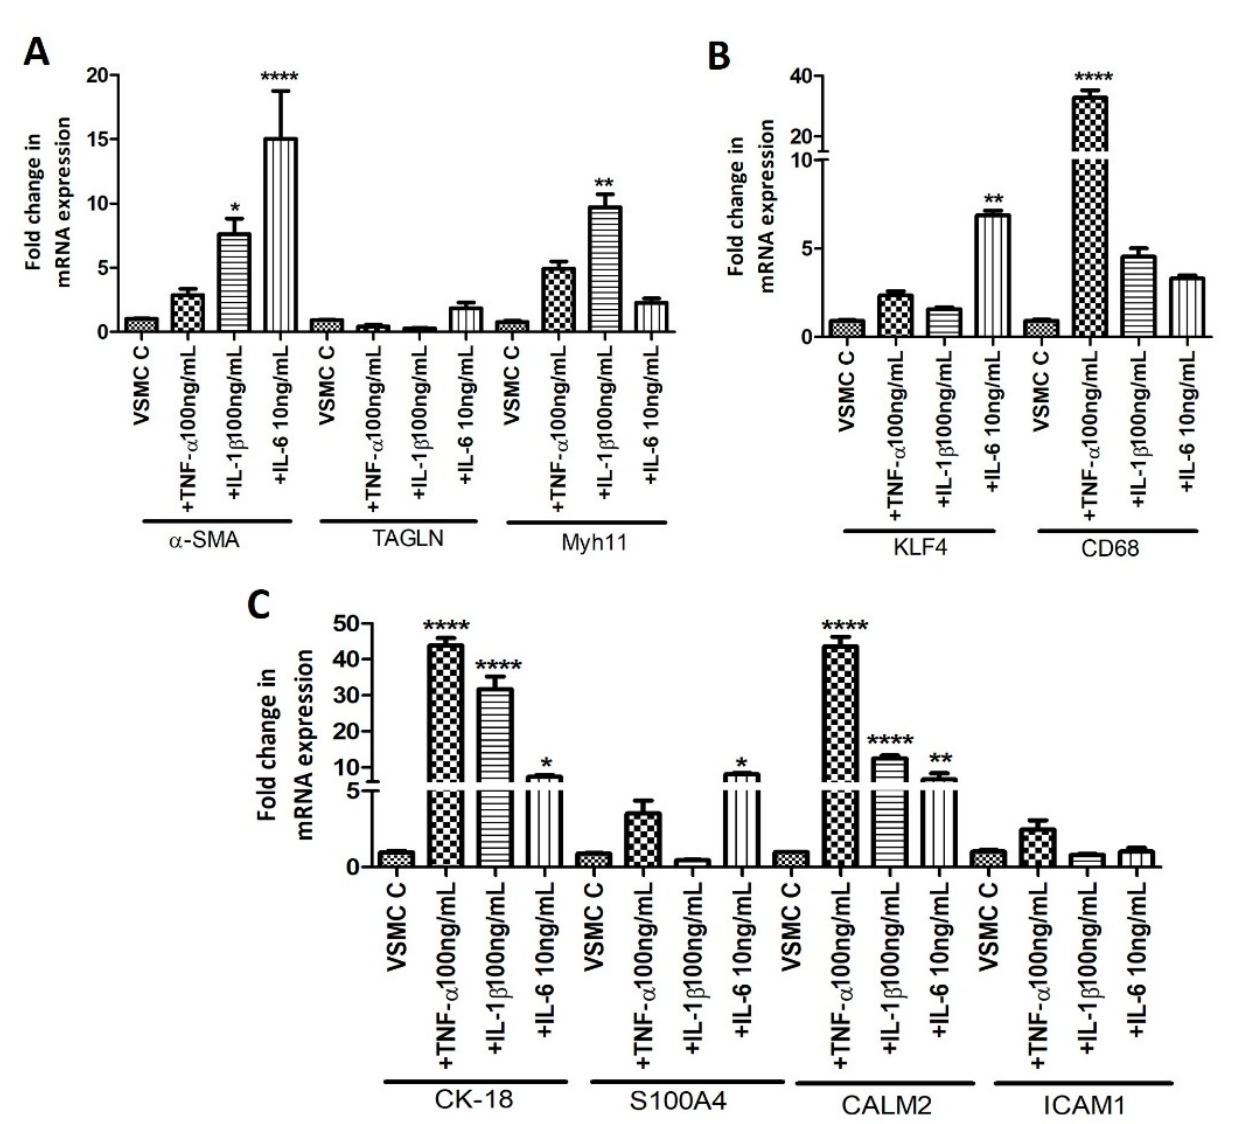
Figure 4. RT-qPCR data for the effects of pro-inflammatory cytokines IL-6, IL-1 β , and TNF- α on VSMCs phenotype markers. Panel ( A ) shows qRT-PCR data for α -SMA, TAGLN, and Myh11; Panel Figure 4. RT ‐ qPCR data for the effects of pro ‐ inflammatory cytokines IL ‐ 6, IL ‐ 1 β , and TNF ‐α on ( B ) shows qRT-PCR for CK-18, S100A4, CALM2, and ICAM1; and Panel ( C ) shows qRT-PCR for VSMCs phenotype markers. Panel ( A ) shows qRT ‐ PCR data for α‐ SMA, TAGLN, and Myh11; Panel KLF4 and CD68. Alpha-smooth muscle actin ( α -SMA), transgelin (TAGLN), Myosin Heavy Chain ( B ) shows qRT ‐ PCR for CK ‐ 18, S100A4, CALM2, and ICAM1; and Panel ( C ) shows qRT ‐ PCR for 11 smooth muscle (Myh11), cytokeratin (CK)-18, S100 protein A4 (S100A4), calmodulin 2 (CALM2), KLF4 and CD68. Alpha ‐ smooth muscle actin ( α‐ SMA), transgelin (TAGLN), Myosin Heavy Chain Intercellular Adhesion Molecule (ICAM)1, Krüppel-like factor 4 (KLF4). α -SMA, TAGLN, and Myh11 (markers for contractile vascular smooth muscle cells (VSMCs)); CK-18, S100A4, CALM2, and ICAM1 (markers for proliferative VSMCs); and KLF4 (a marker for de-differentiated VSMCs). All data are presented as mean ± standard deviation (SD). p < 0.05 is considered statistically significant. * p < 0.05, ** p < 0.01 and **** p <